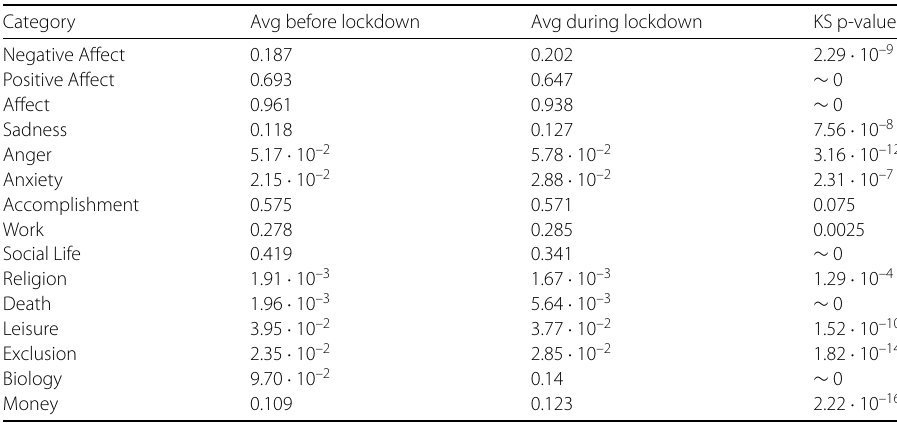
Table 1 p-values of Kolmogorov-Smirnov tests for YouTube content differences displayed by Fig. 6, i.e. content differences before and during the lockdown